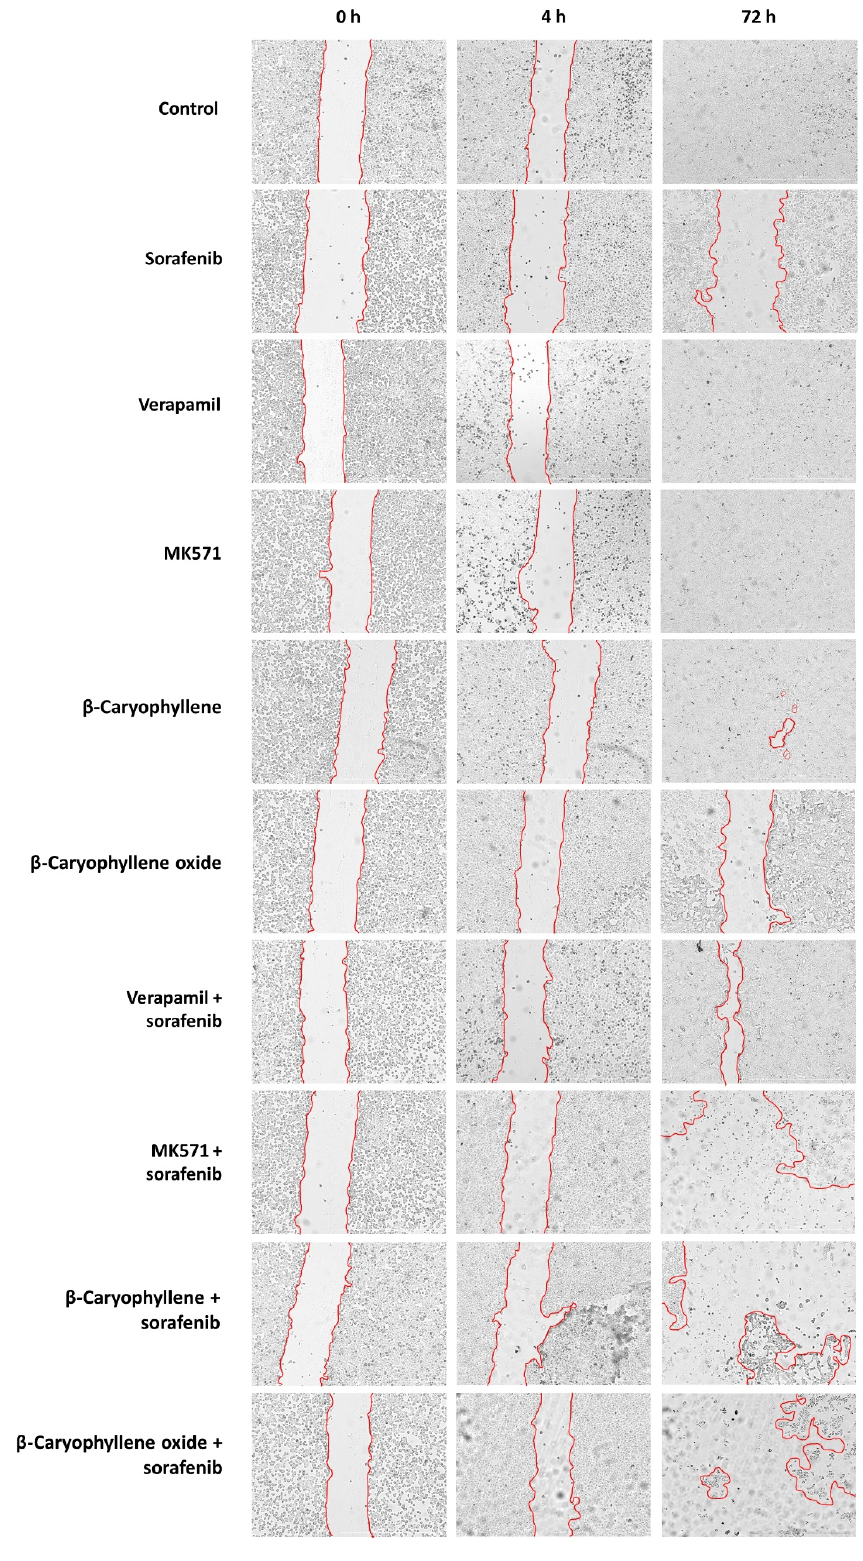
Figure 14. Wound images of Bx-PC3 cells at 0 h, 4 h, and 72 h after treatment with sorafenib (10 µg/mL), verapamil (1 µg/mL), MK571 (1 µg/mL), β -caryophyllene (10 µg/mL), and β -caryophyllene oxide (10 µg/mL), alone or in combination with the anticancer drug. Scale bar: 1000 µm.